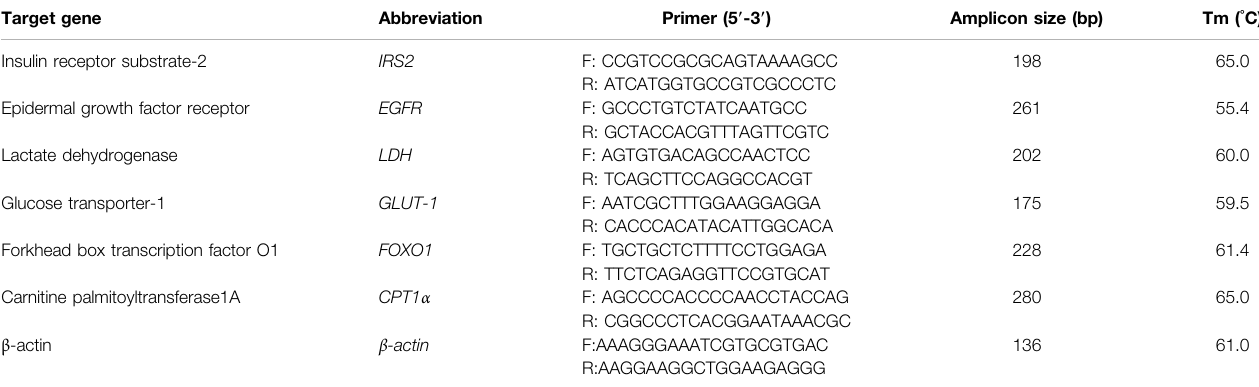
TABLE 2 | Transcriptome veri fi cation gene primer sequences.